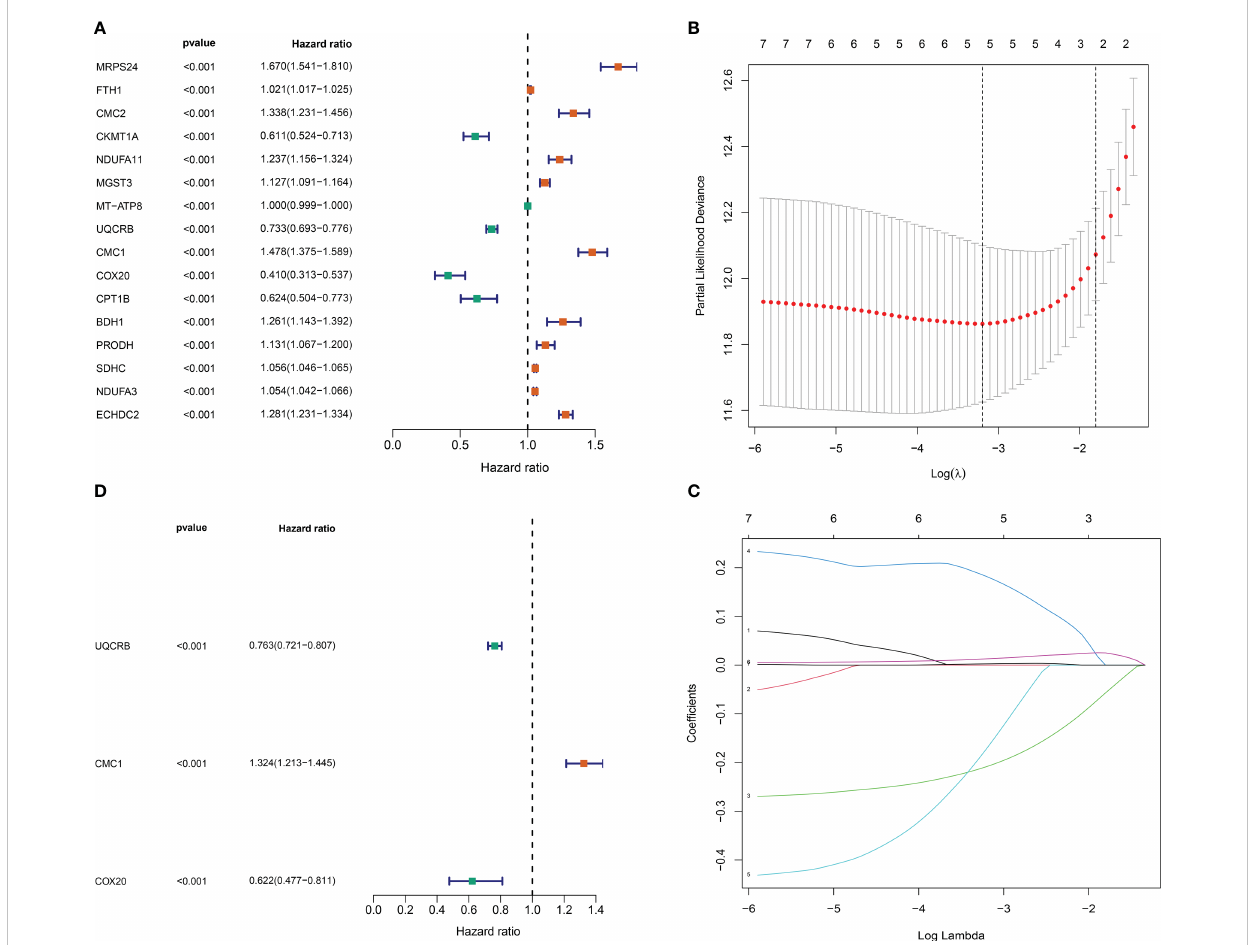
FIGURE 3 Mitochondrial-associated differential gene prognostic model construction. (A) One-way Cox risk regression for mitochondria-associated differential genes; (B) vertical coordinate is Binomial Deviance (dichotomous abnormality). (C) Each curve in the fi gure represents the trajectory of each independent variable coef fi cient. The vertical coordinate is the value of the coef fi cient, the lower horizontal coordinate is log( l ), and the upper horizontal coordinate is the number of non-zero coef fi cients in the model at this point. (D) Mitochondria-associated differential genetic multifactorial Cox risk